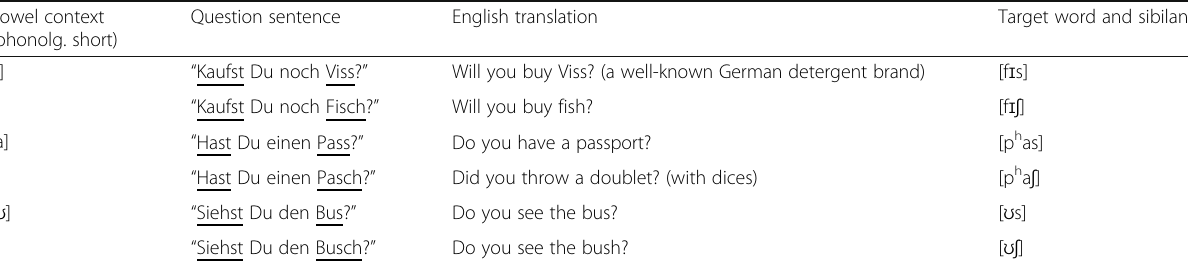
Table 2 The three pairs of stimulus sentences used in the perception experiment Vowel context (phonolg. short)